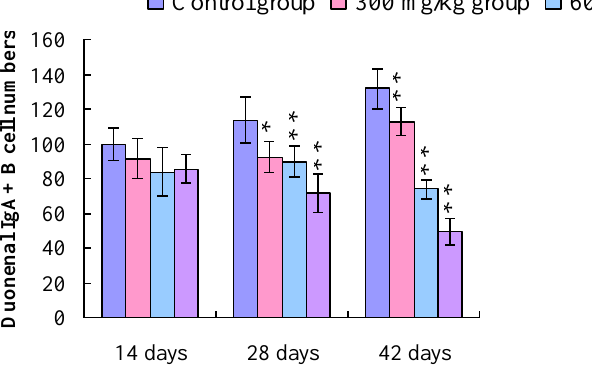
Figure 2. Change in the IgA + B cell number in the lamina propria (LP) of the duodenum and